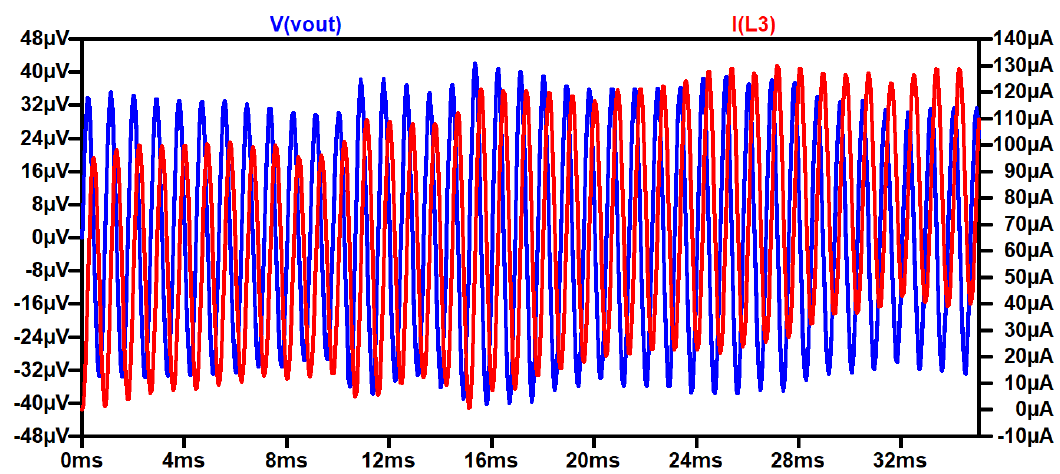
Figure 15. The output voltage and current response of the circuit with Si-MOSFET-based switch and LC load.